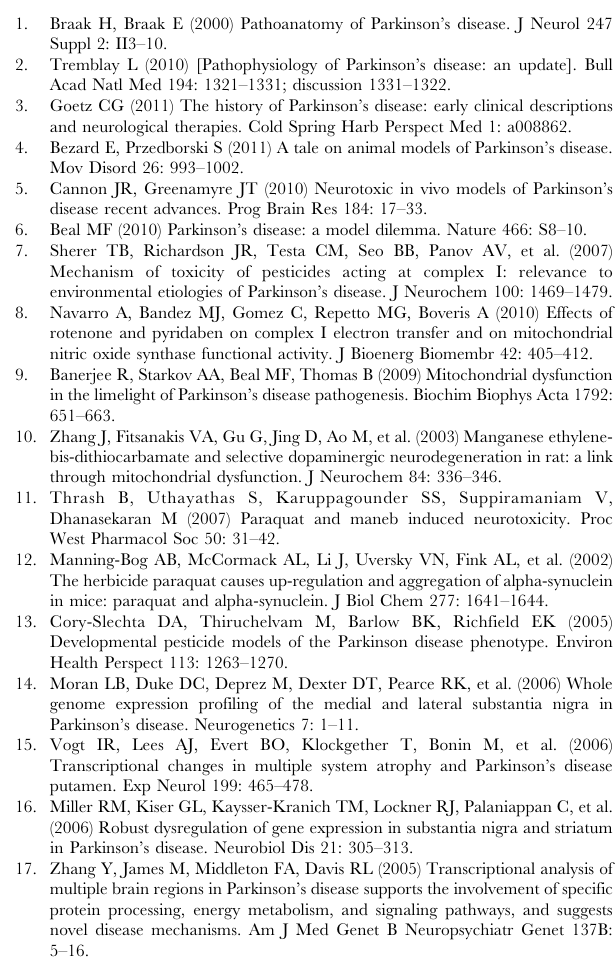
Table S5 Top ten canonical pathways in VMB of maneb + paraquat mouse model of PD Table S6 Top ten canonical pathways in STR of paraquat mouse model of PD Table S7 Top ten canonical pathways in STR of pyridaben mouse model of PD Table S8 Top ten canonical pathways in STR of maneb + paraquat mouse model of